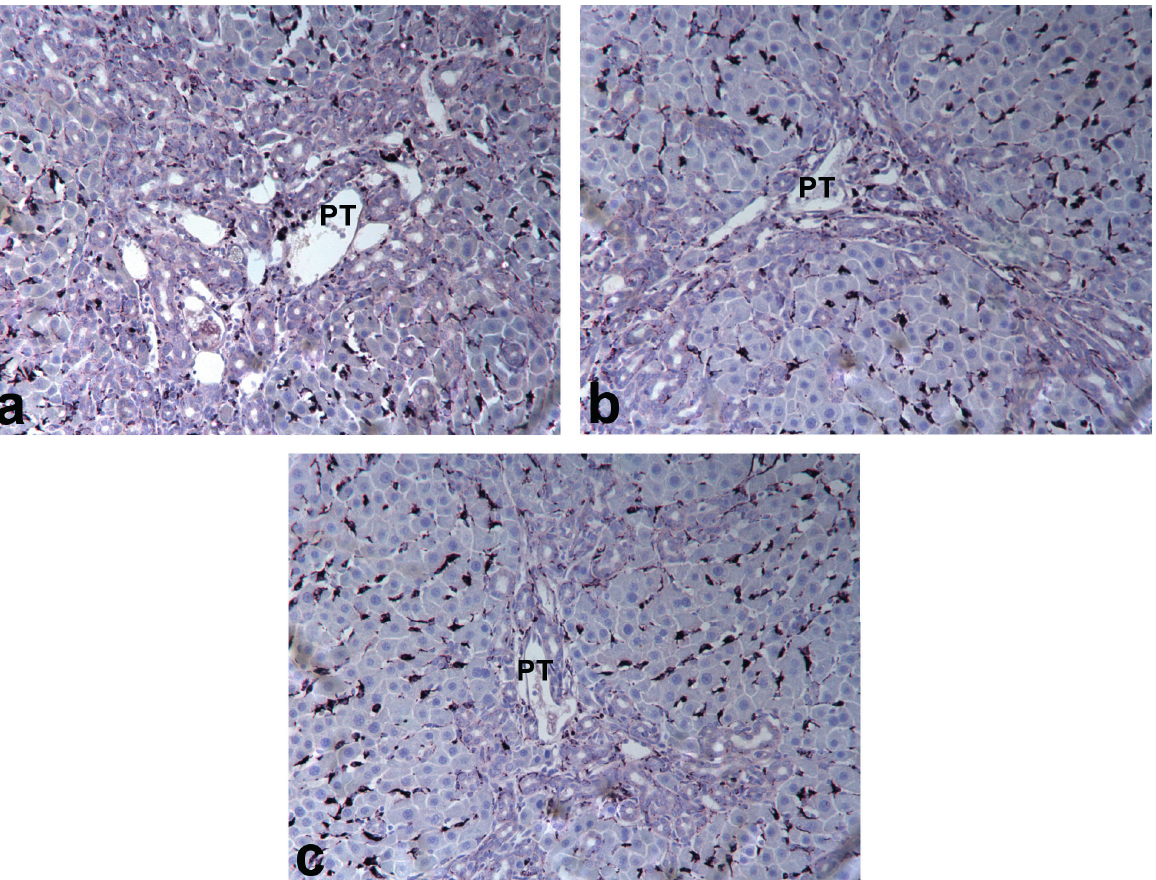
Figure 7 - Representative microphotographs of Cd68 positive macrophages in the periportal area 6 weeks after Bdl. a ) Group Bdl; b ) Group Bdl+Am ; c ) Group Bdl+ Am . Portal tract (PT). Magnifi cation of 0 1